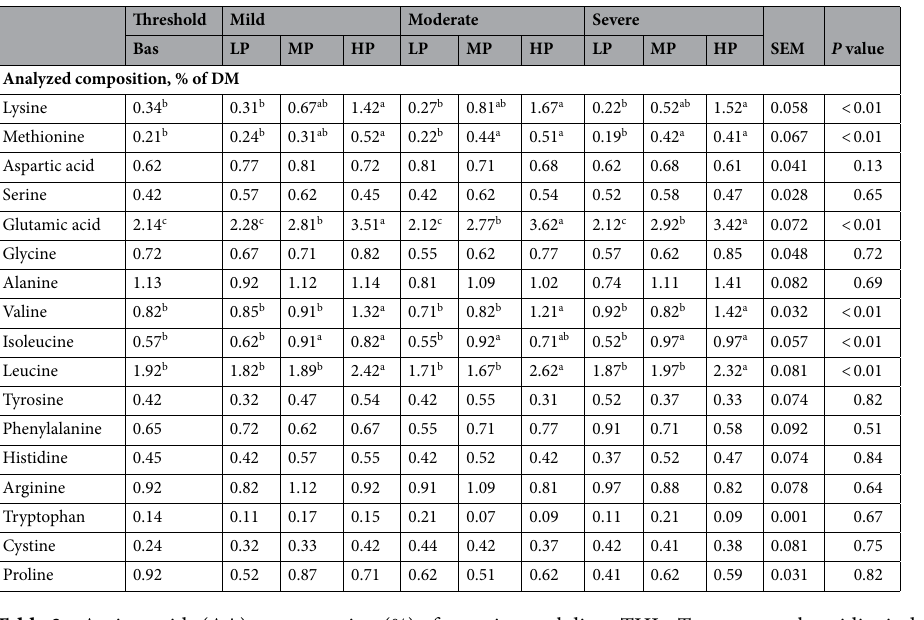
Table 3. Amino acids (AA) concentration (%) of experimental diets. THI = Temperature humidity index, THI = (1.8 × Tdb + 32) – [(0.55 – 0.0055 × RH) × (1.8 × Tdb − 26.8). Threshold = THI 70 to 73, Mild = THI 74 to 76, Moderate = THI 81 to 83, Severe = THI 89 to 91. LP = Low protein (12.5%), MP = Medium protein (15%), HP = High protein (17.5%). a, b Values with different superscripts in the same row differ significantly at P <